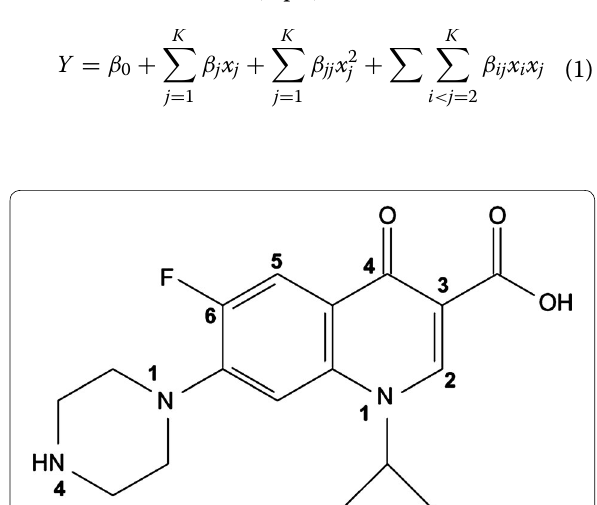
Fig. 1 Chemical structure of ciprofloxacin (C 17 H 18 FN 3 O 3